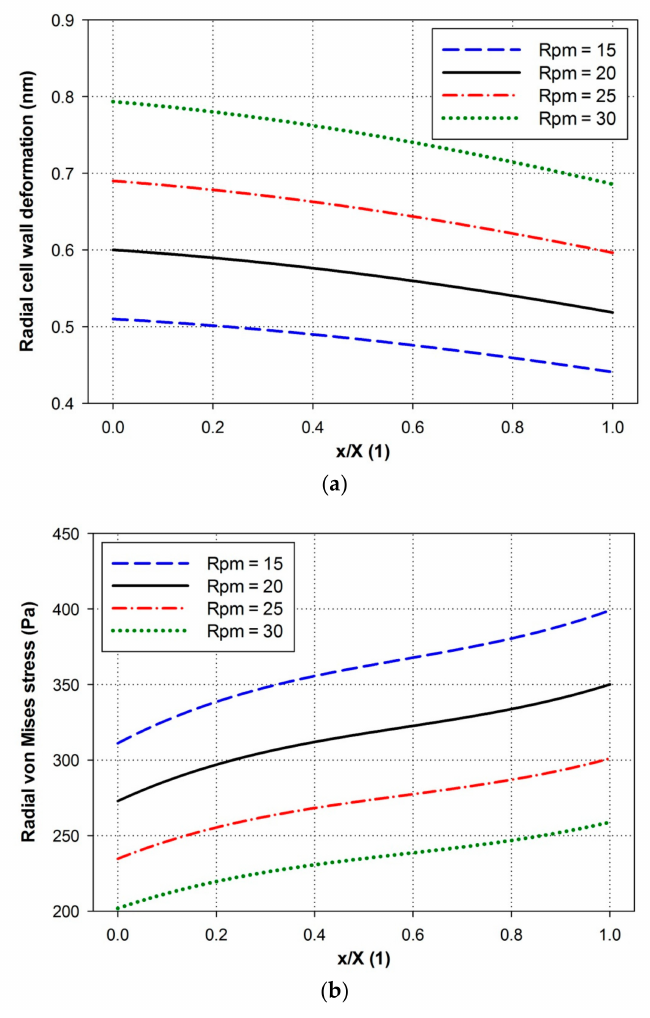
Figure 9. Effect of paddle wheel rotational speeds (rpm) on radial ( a ) microalgal cell deformation (nm) and ( b ) von Mises stress